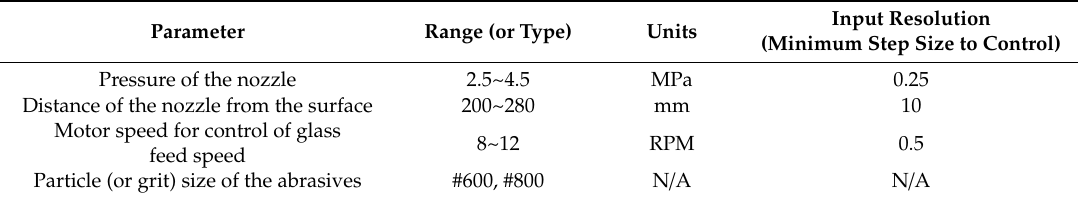
Table 1. Process inputs and their